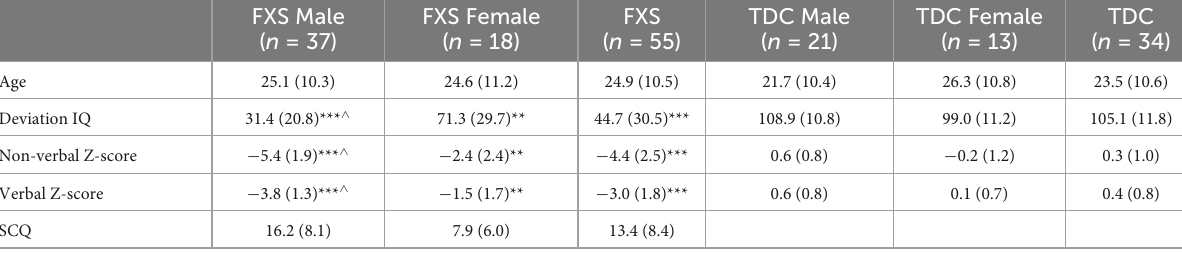
TABLE 1 Demographic characteristics of fragile X syndrome (FXS) and TDC